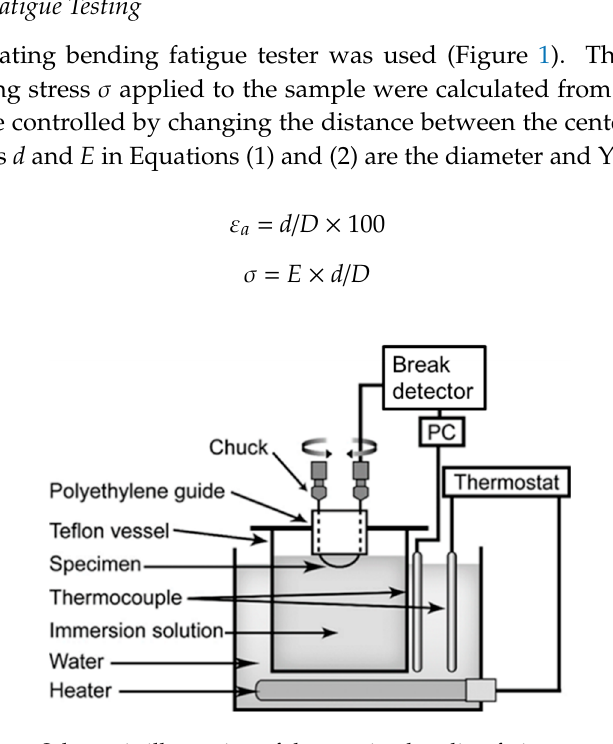
Figure 1. Schematic illustration of the rotating bending fatigue test setup.